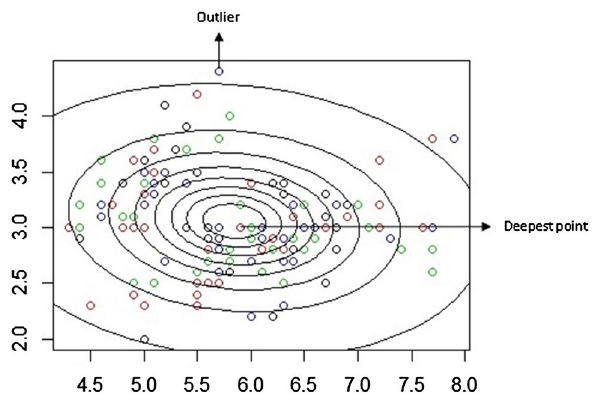
Fig. 1 Mahalanobis depth